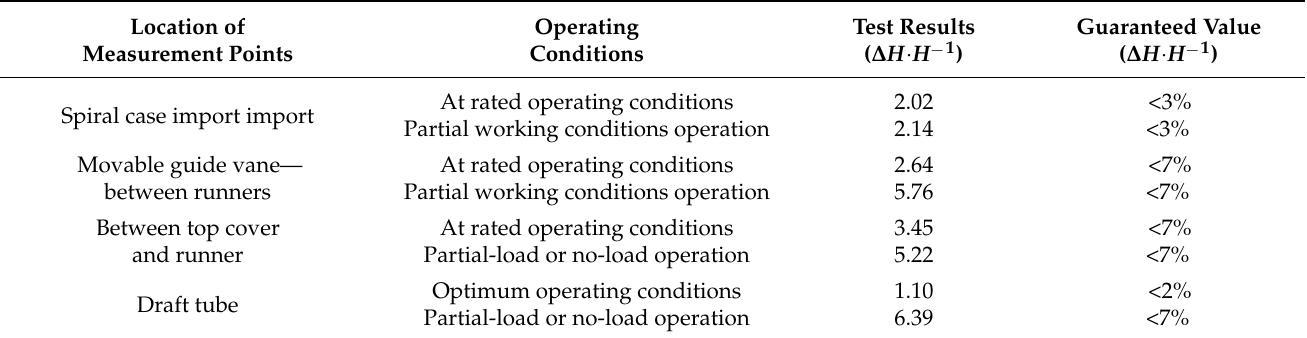
Table 5. Hydraulic turbine working conditions pressure pulsation